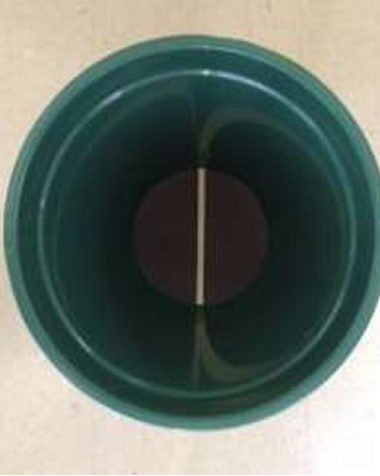
Figure 1 View of the fluorescent tape on the bottom of the inside of the bucket.